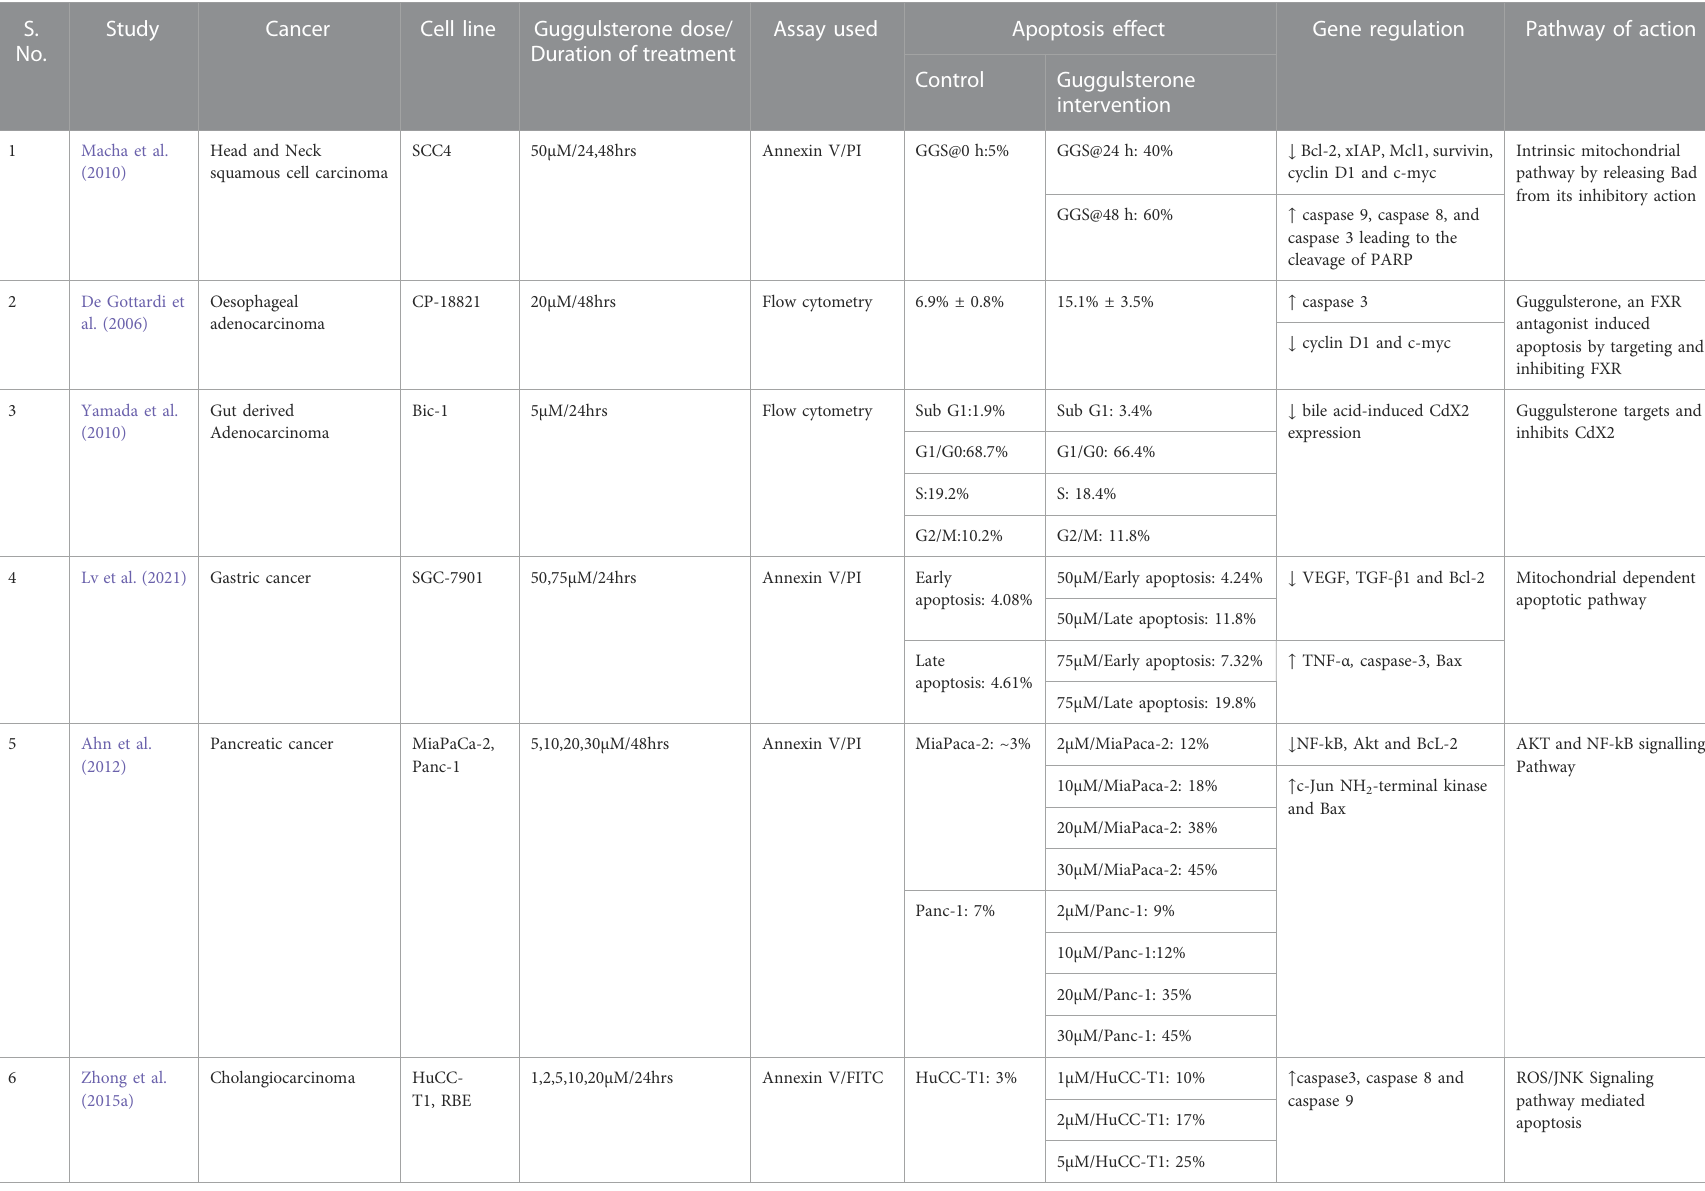
TABLE 1 Main characteristics of the 23 studies included in the meta-analysis related to the role of Guggulsterone and apoptosis induction in cancer cells. S.